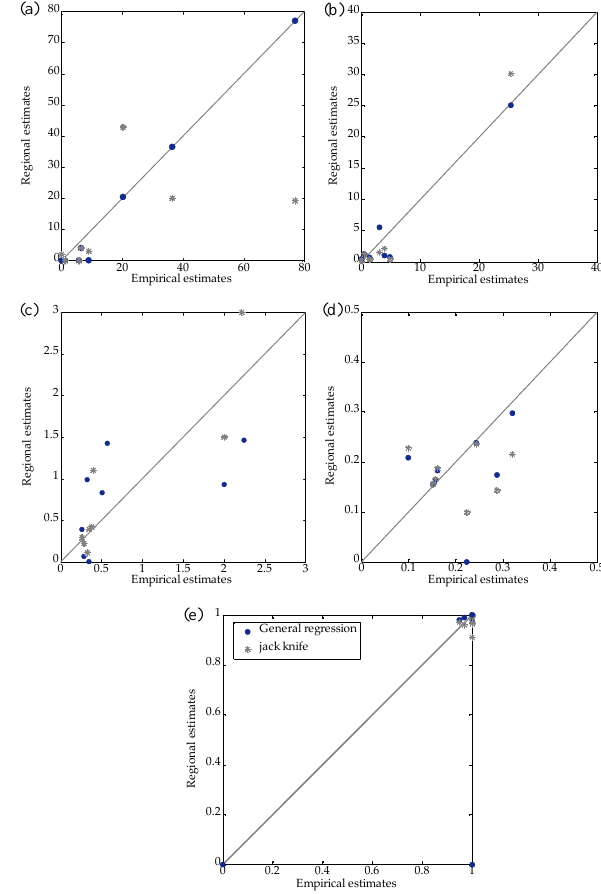
Fig. 11. Scatter plot of observed parameters vs. predicted parame- ters of the stochastic index flow model. Graphs (a) and (b) represent µ and σ parameters of the normal distribution. Graphs (c) and (d) represent κ and λ parameters of the GEV distribution, and Graph (e) is the scatter plot of the p nz values (in probability